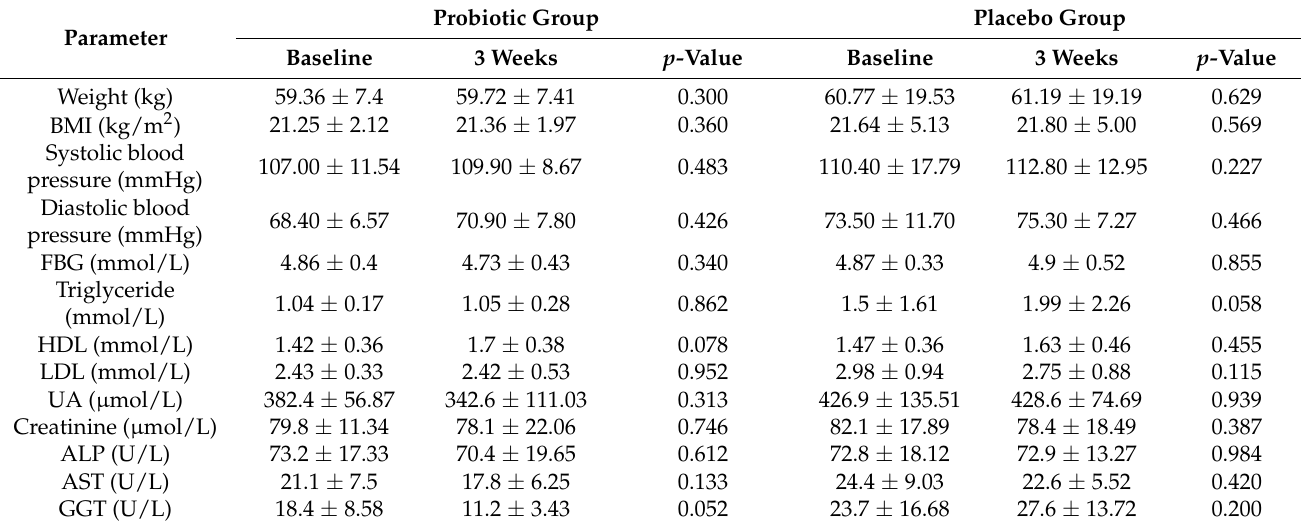
Table 3. Changes of blood parameters and anthropometric measurements in two groups under LTL1879 intervention.